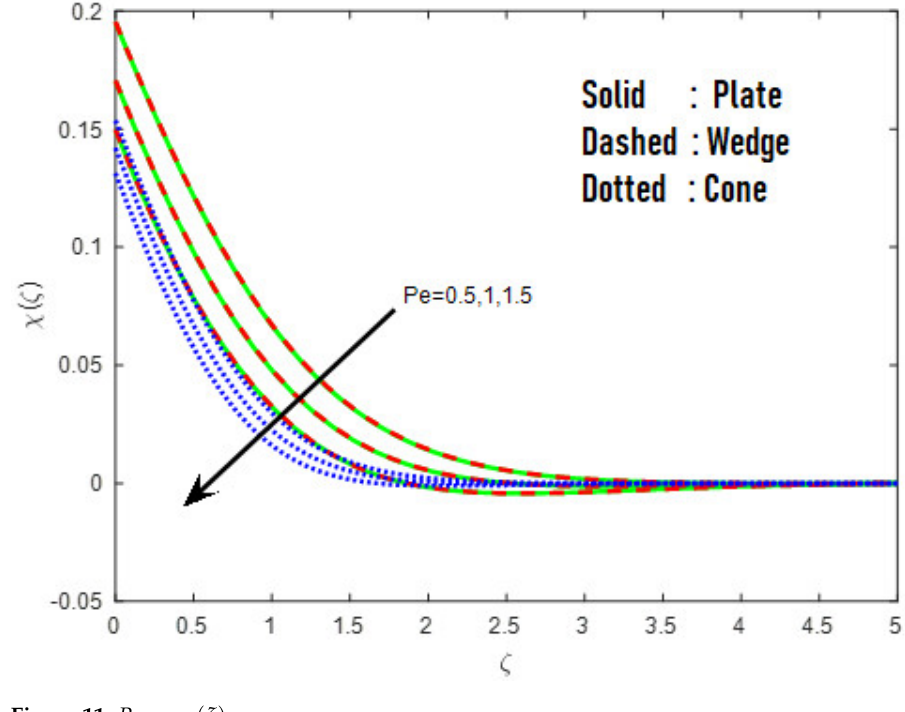
Pe vs. Figure 11. Pe vs. χ ( ζ ) . Figure 11. Figure 11. Pe vs.